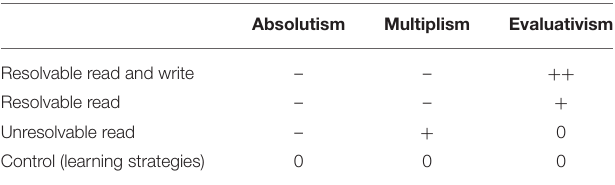
TABLE 1 | Predicted pattern of effects (FREE-GST,